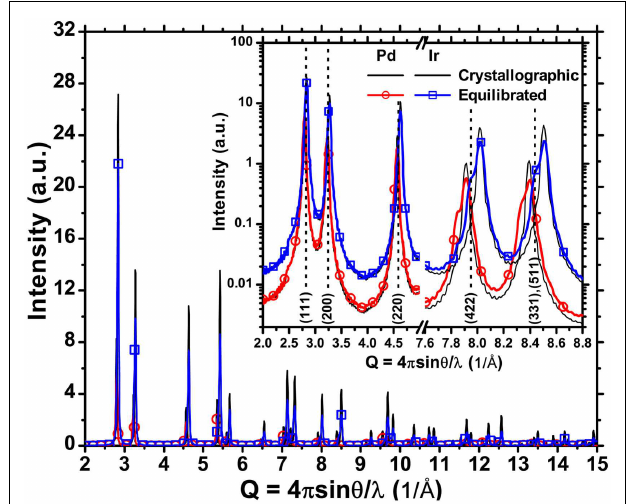
FIGURE 6 | X-ray powder diffraction pattern simulated by DSE from the (“equilibrated”)TAM of cylindrical nanocrystals ( D = H = 16nm) with edge dislocations (line), and corresponding ideally perfect (“crystallographic”) nanocrystals (dash) . Results are shown for Pd (red circular dot) and Ir (blue square dot), having respectively larger and smaller separation distance between partial dislocations.